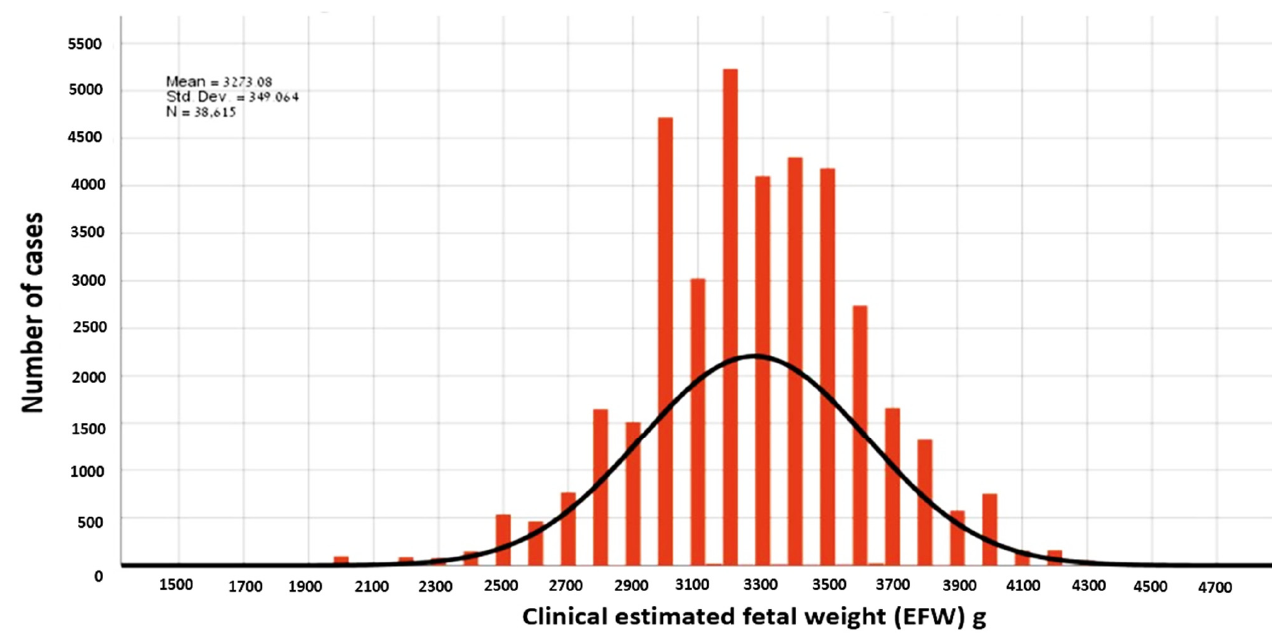
Figure 2. Distribution of clinical estimated fetal weight.